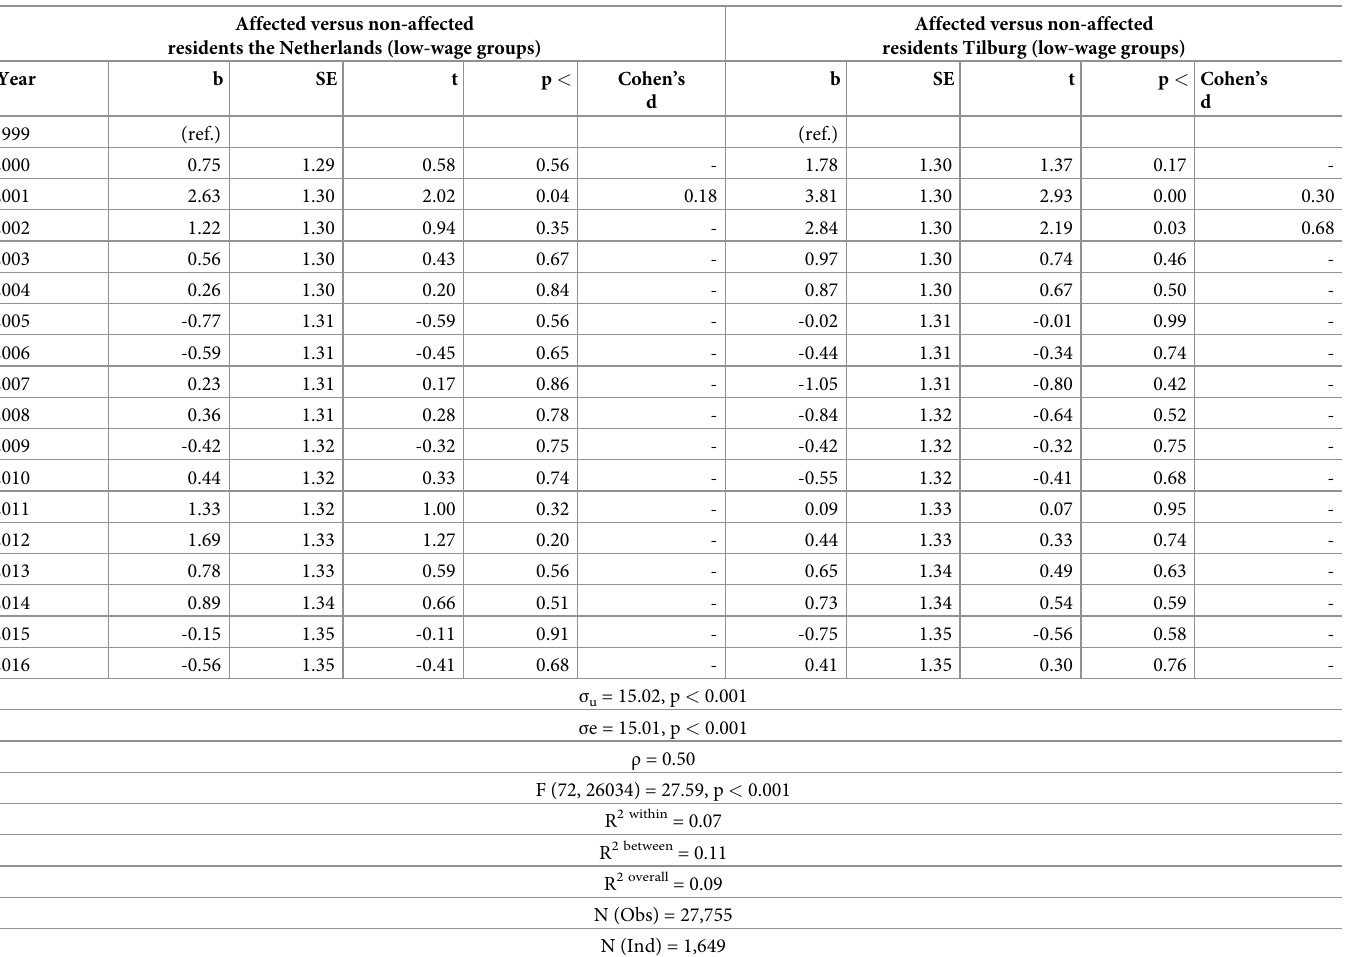
Table 5. Results of fixed-effects linear panel regression models for low-wages groups with employment security as dependent variable (1999–2016). Affected versus non-affected residents the Netherlands (low-wage groups)